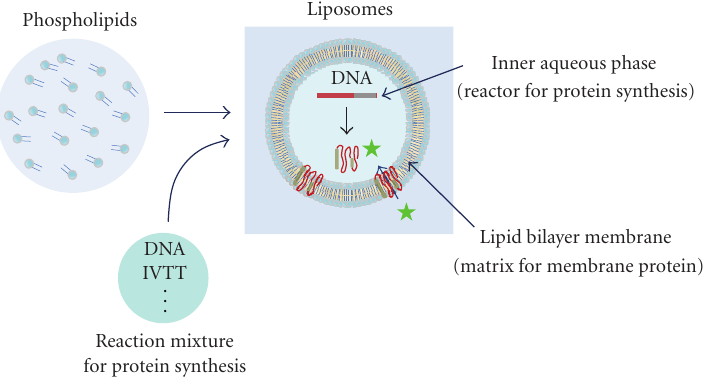
Figure 4: Liposomes as a platform for in vitro protein synthesis. Reaction mixture for protein synthesis constitutes an inner aqueous phase of liposome, in which protein is synthesized from a DNA. Membrane protein synthesized inside liposome can be embedded into a lipid bilayer